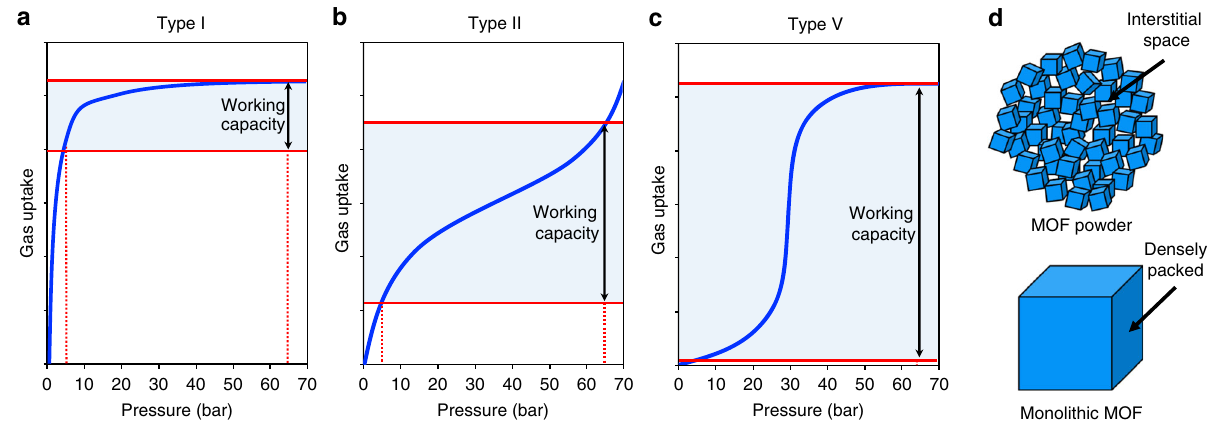
Fig. 1 Gas adsorption isotherms and particle densi fi cation. a – c Variations in gas adsorption isotherms and corresponding changes in working capacity for Type I, II and V isotherms, respectively. d Representation of the abundant interstitial space amongst non-densi fi ed MOF particles compared with a densi fi